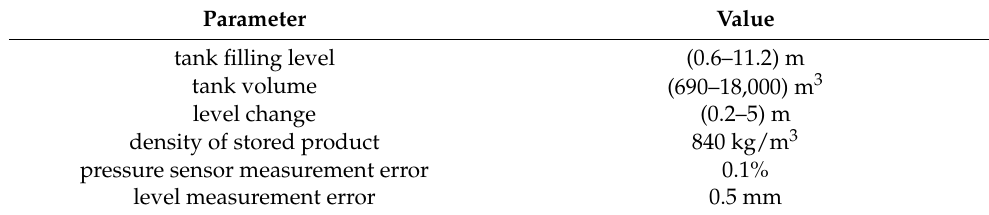
Table 2. The input parameters for modeling of the mass transfer uncertainty.